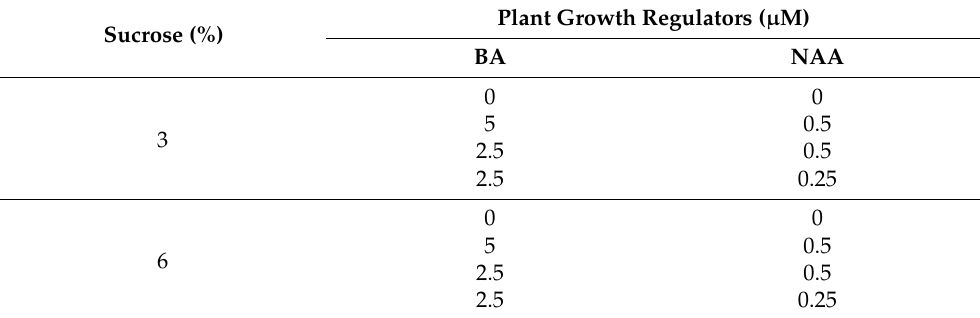
Table 1. Combination of the